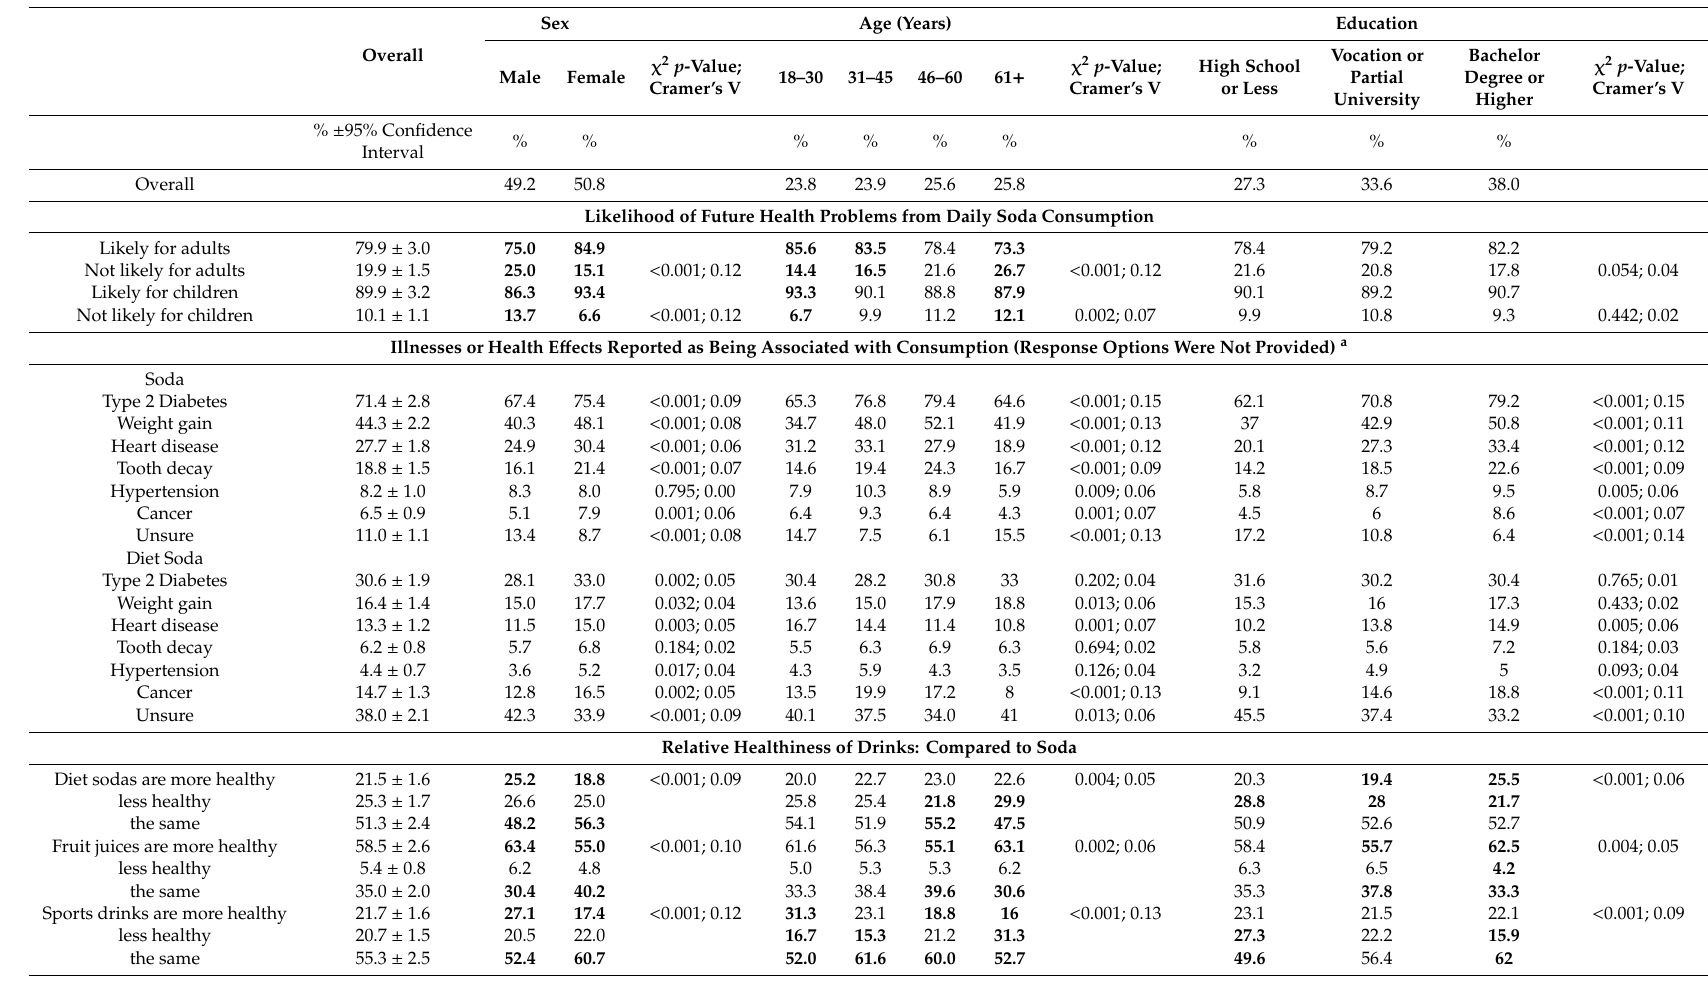
Table 1. Soda-related knowledge and beliefs by sex, age and education ( n =